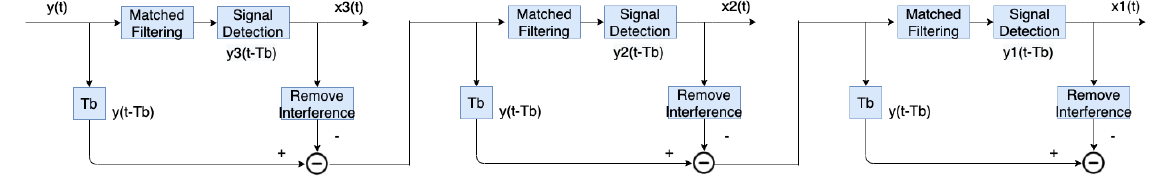
Figure 2. SIC receiver